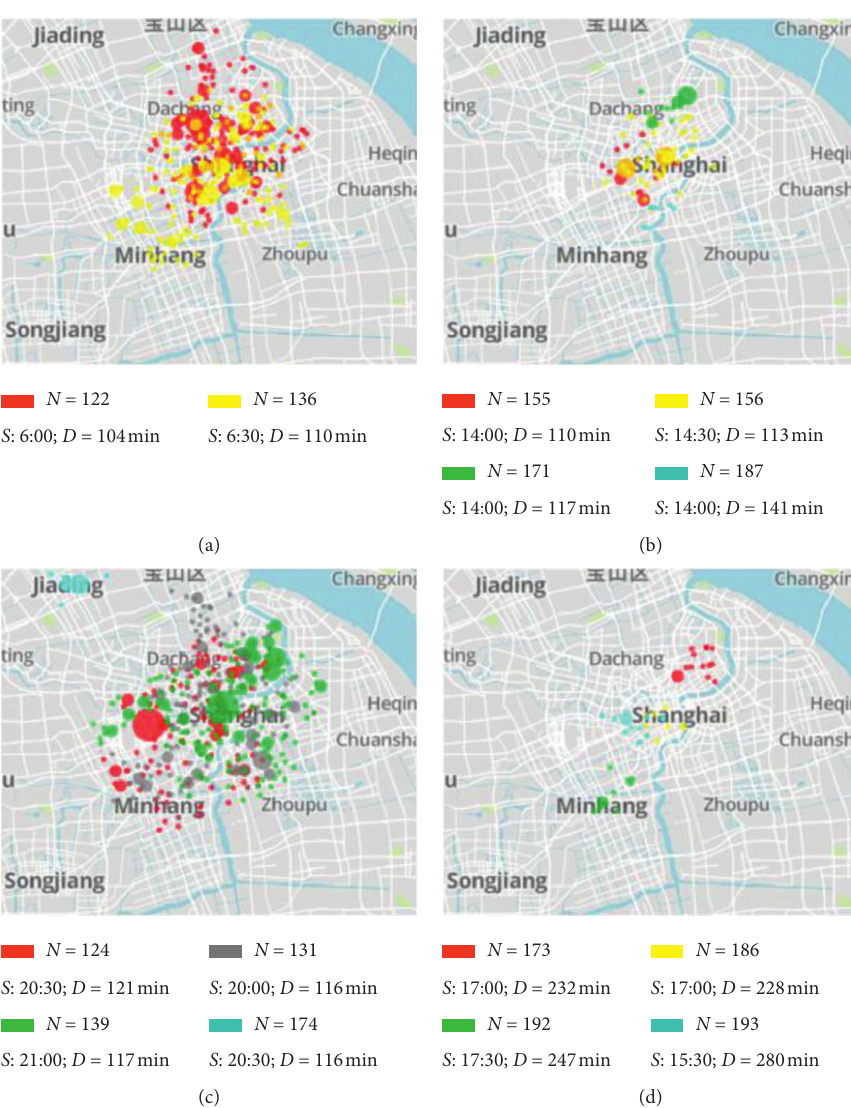
Figure 13: Sample activity pattern related to entertainment. Size of the points represents the relative activity frequency. N : cluster number; S : start time; D : duration. (a) Shopping in the early morning. (b) Shopping in the noon. (c) Shopping in the twilight. (d) Shopping in the late